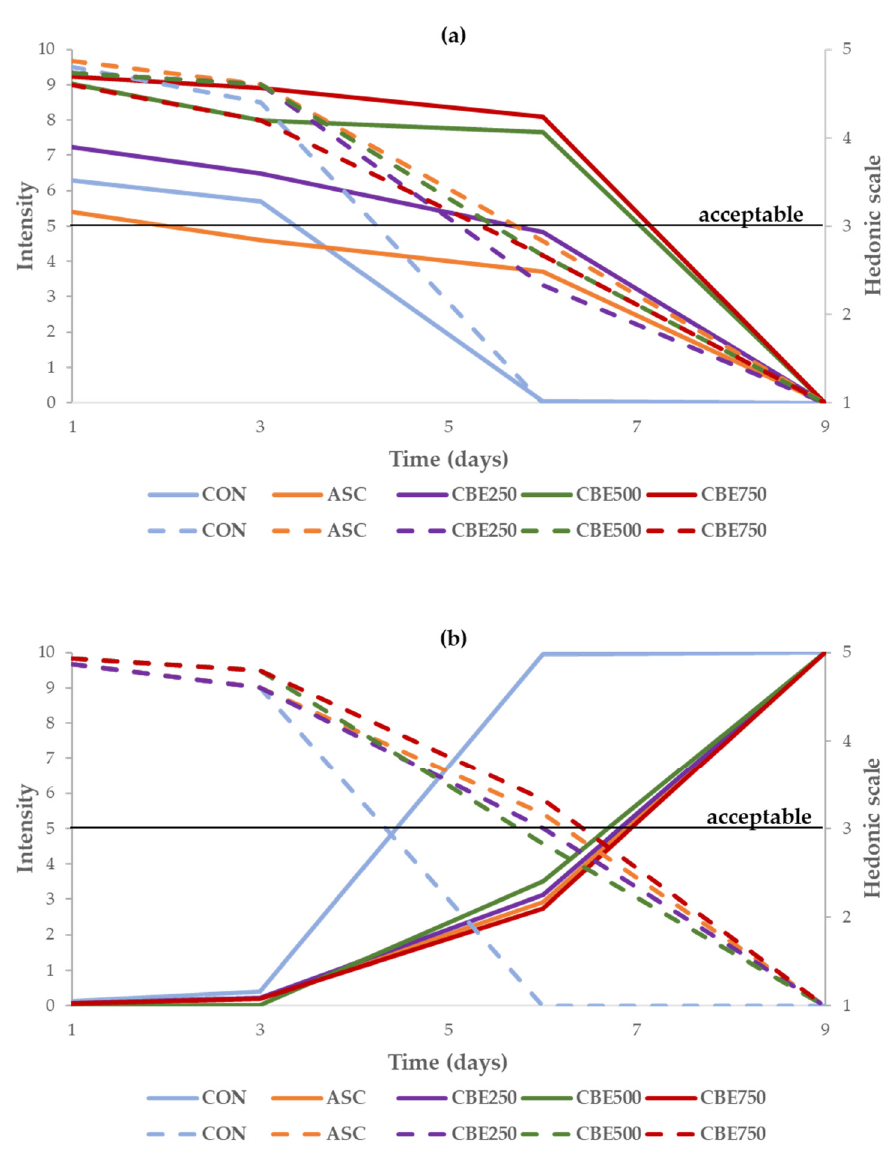
Figure 5. Visual attributes ( a ) red colour and ( b ) surface discolouration evaluated by the consumers during shelf-life (days 1, 3, 6, and 9) for raw patties. CON: without antioxidant; ASC: with ascorbic acid; CBE250: 250 ppm of Colombian berry extract; CBE500: 500 ppm of Colombian berry extract; CBE750: 750 ppm of Colombian berry extract. Intensity of the attributes was evaluated using a linear structured scale from 0 (minimum attribute intensity) to 10 (maximum attribute intensity). Acceptance was evaluated using a five-point hedonic scale (1 = not acceptable, 5 = excellent).